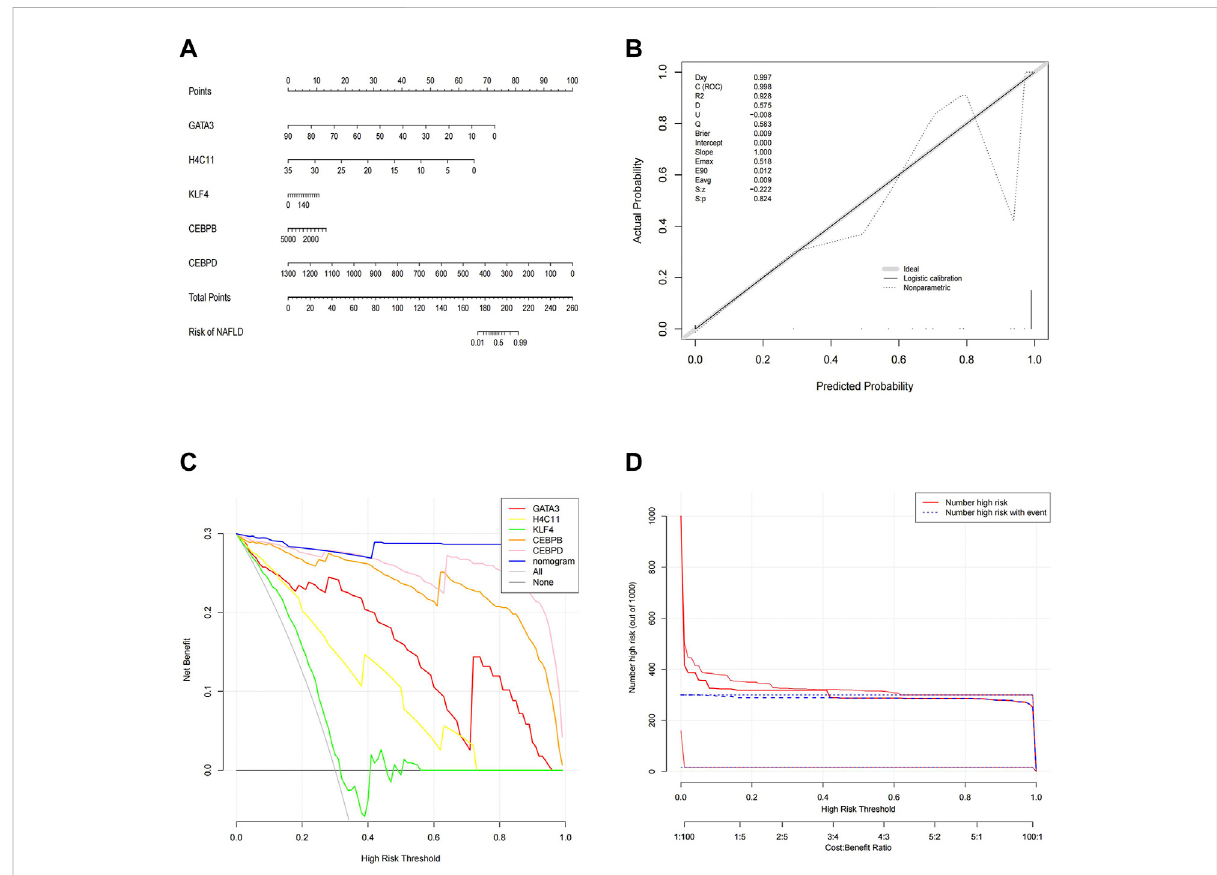
FIGURE 4 Construction and validation of a nomogram. (A) Nomogram of diagnostic biomarkers. (B) Calibration curves of the predictive nomogram model. (C) DCA curve to evaluate the clinical application value of the nomogram model. (D) Clinical impact curves of the nomogram model. The nomogram model predicts a risk strati fi cation of 1,000 people. At each high-risk threshold, the number of high-risk curves indicates the number of models classi fi ed as positive (high risk), and the number of high-risk curves indicates the number of true positive